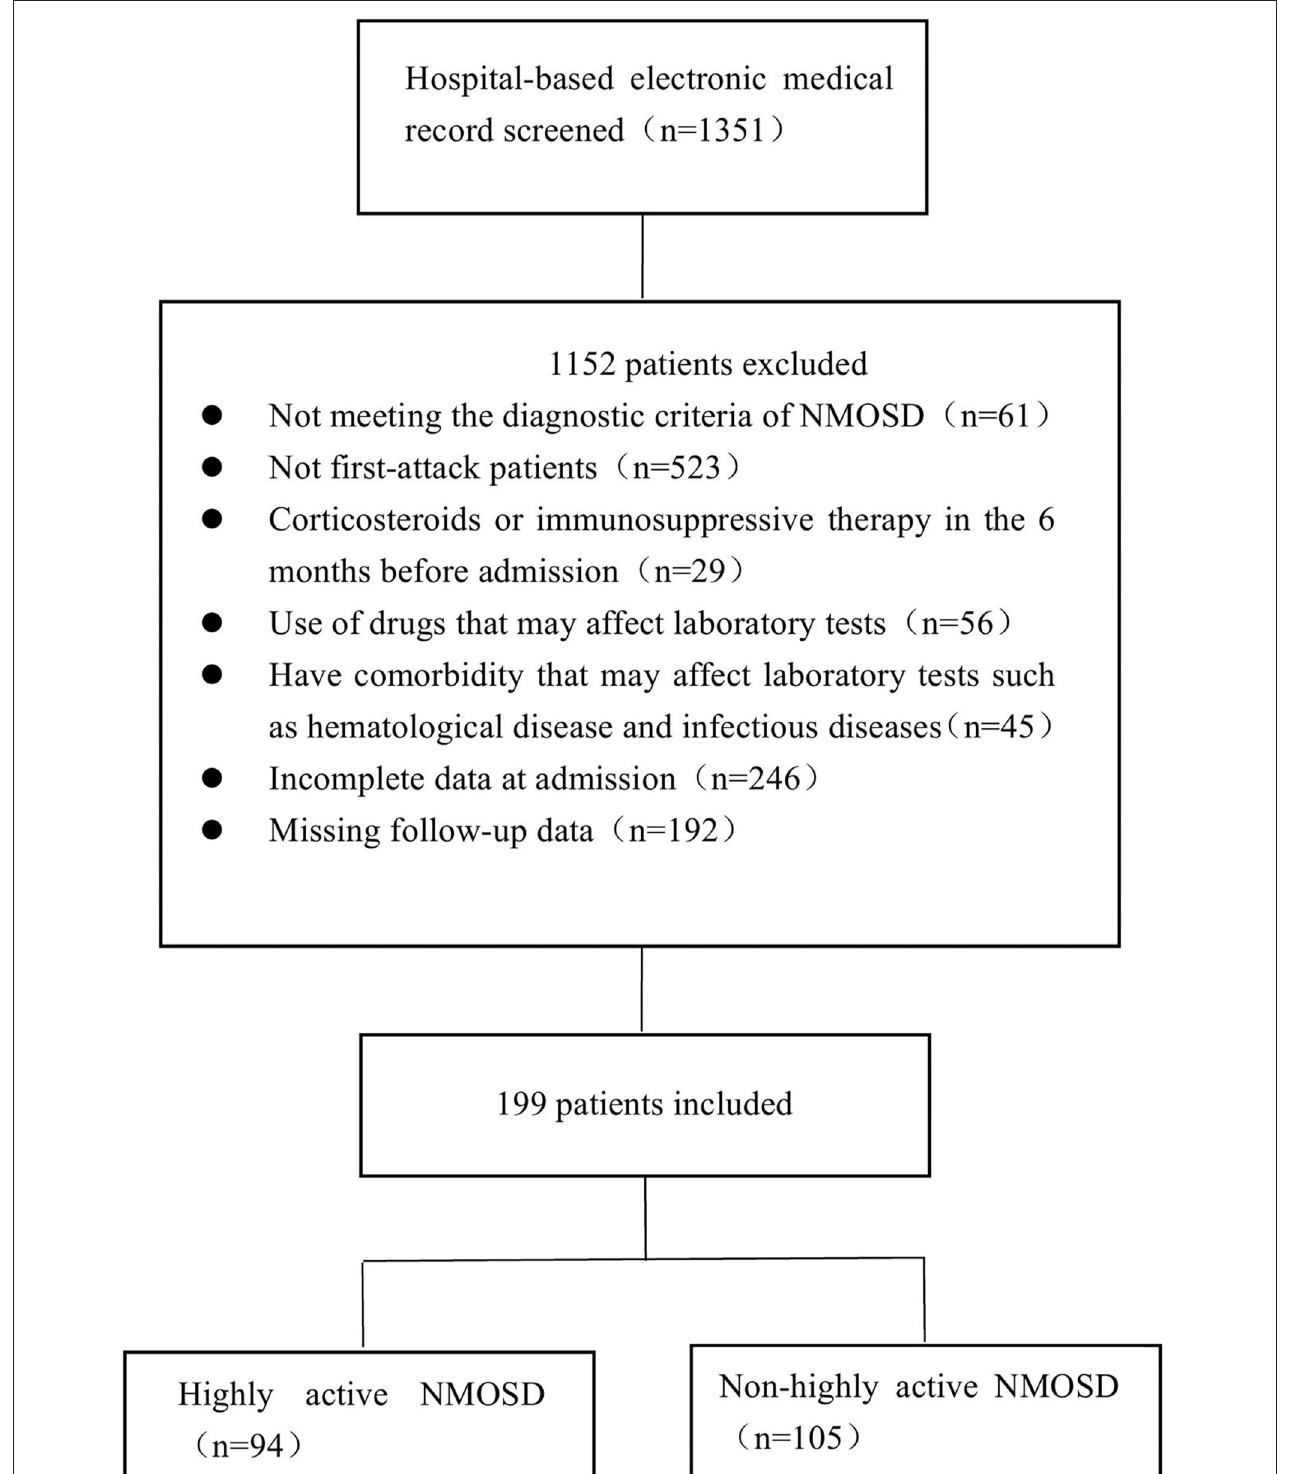
FIGURE 1 | Overview of the patient selection process.